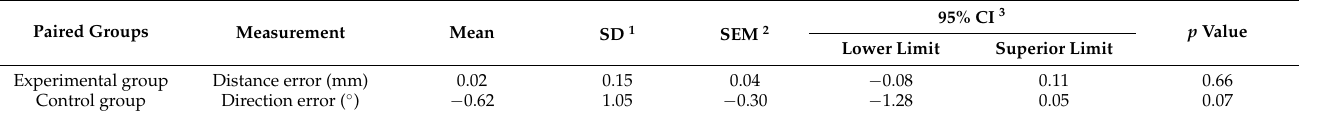
Table 2. Paired t -tests of operative errors between the robot-assisted osteotomy and surgical guide- assisted